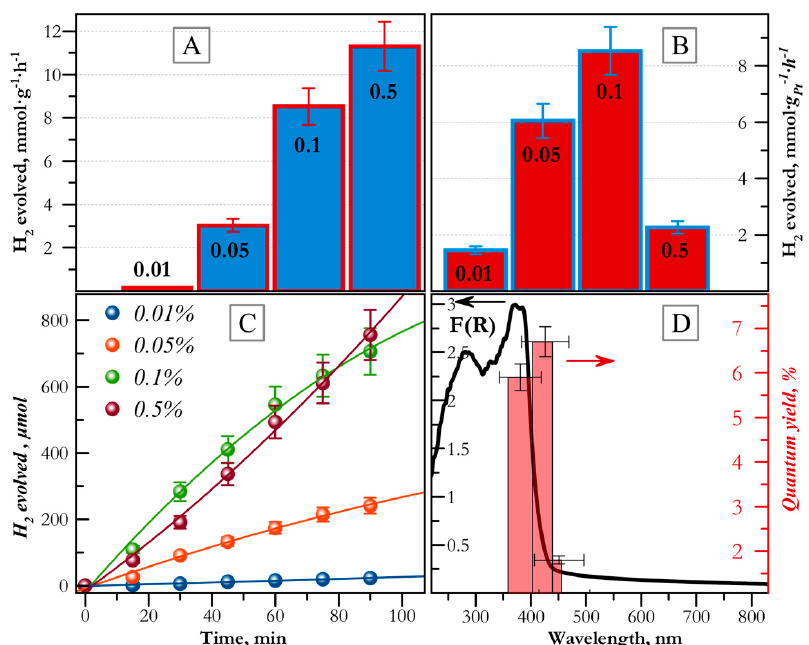
Figure 8. Activity of the Pt x /g-C 3 N 4 photocatalysts in the reaction of hydrogen evolution ( λ = 425 nm) calculated by ( A ) per gram of catalyst; ( B ) per gram of Pt. ( C ) Kinetic dependences of the H 2 production reaction under the action of light for Pt x /g-C 3 N 4 catalysts. ( D ) Dependence of the quantum efficiency on the wavelength for the Pt 0.1 /g-C 3 N 4 catalyst. Adapted with permission from Ref. [103]. 2022,